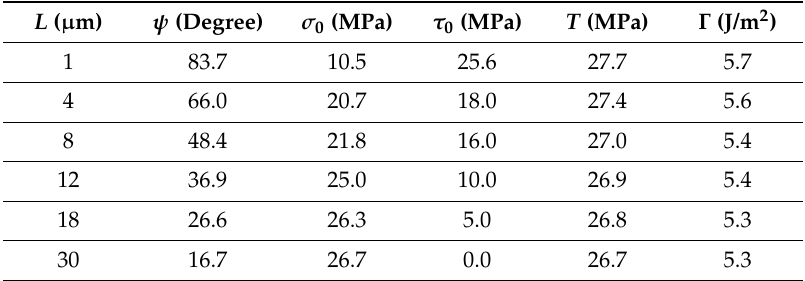
Figure 7. ( a ) Illustration of micro-cantilever beam with pre-crack, ( b ) FEA mesh details (yellow indicates Cu, grey indicates Si), ( c ) normal stress at the crack tip, ( d ) shear stress at the crack tip. Table 2. Mixed-mode fracture analysis